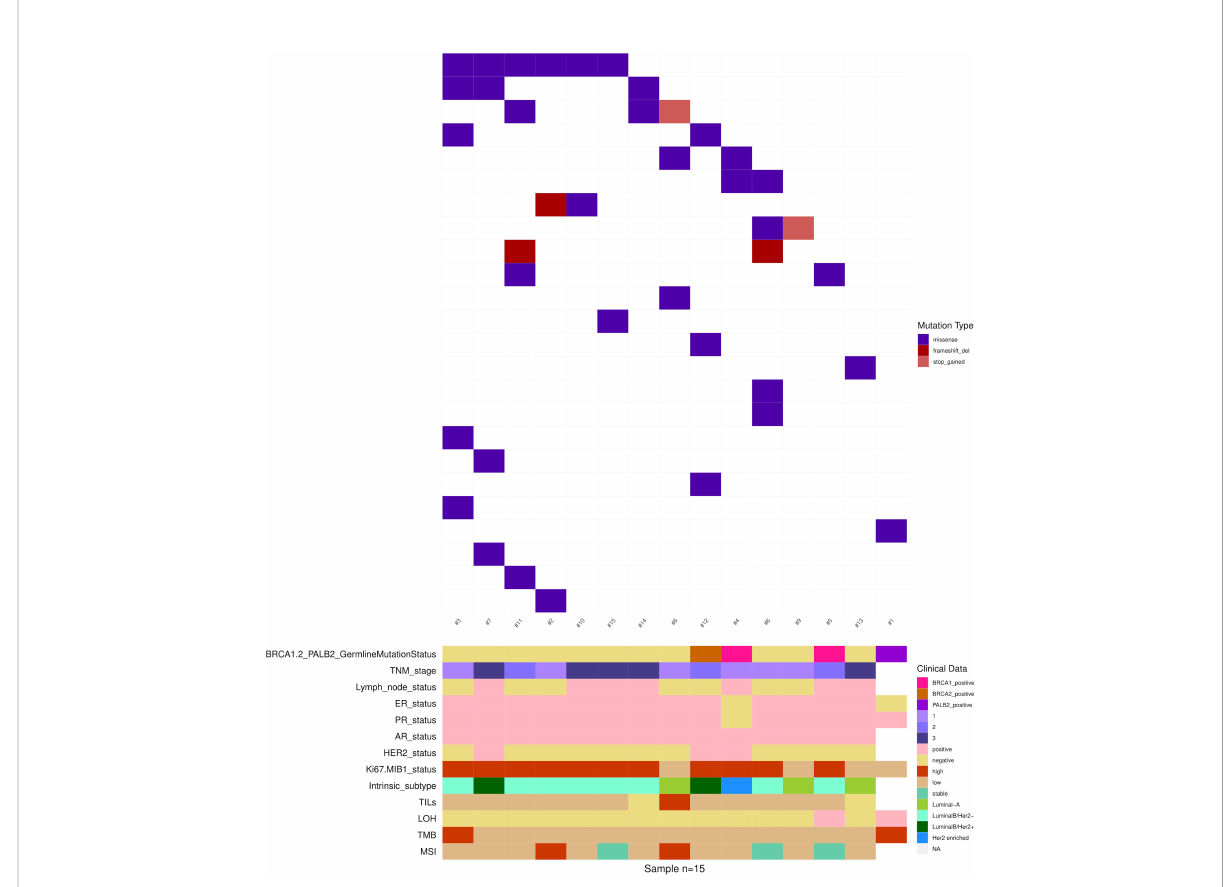
FIGURE 4 Somatic non-synonymous variants in 15 MBCs. Mutated genes are represented as rows, and individual patients are represented as columns. Clinical data, tumor histology and molecular biomarkers investigated are indicated by the horizontal